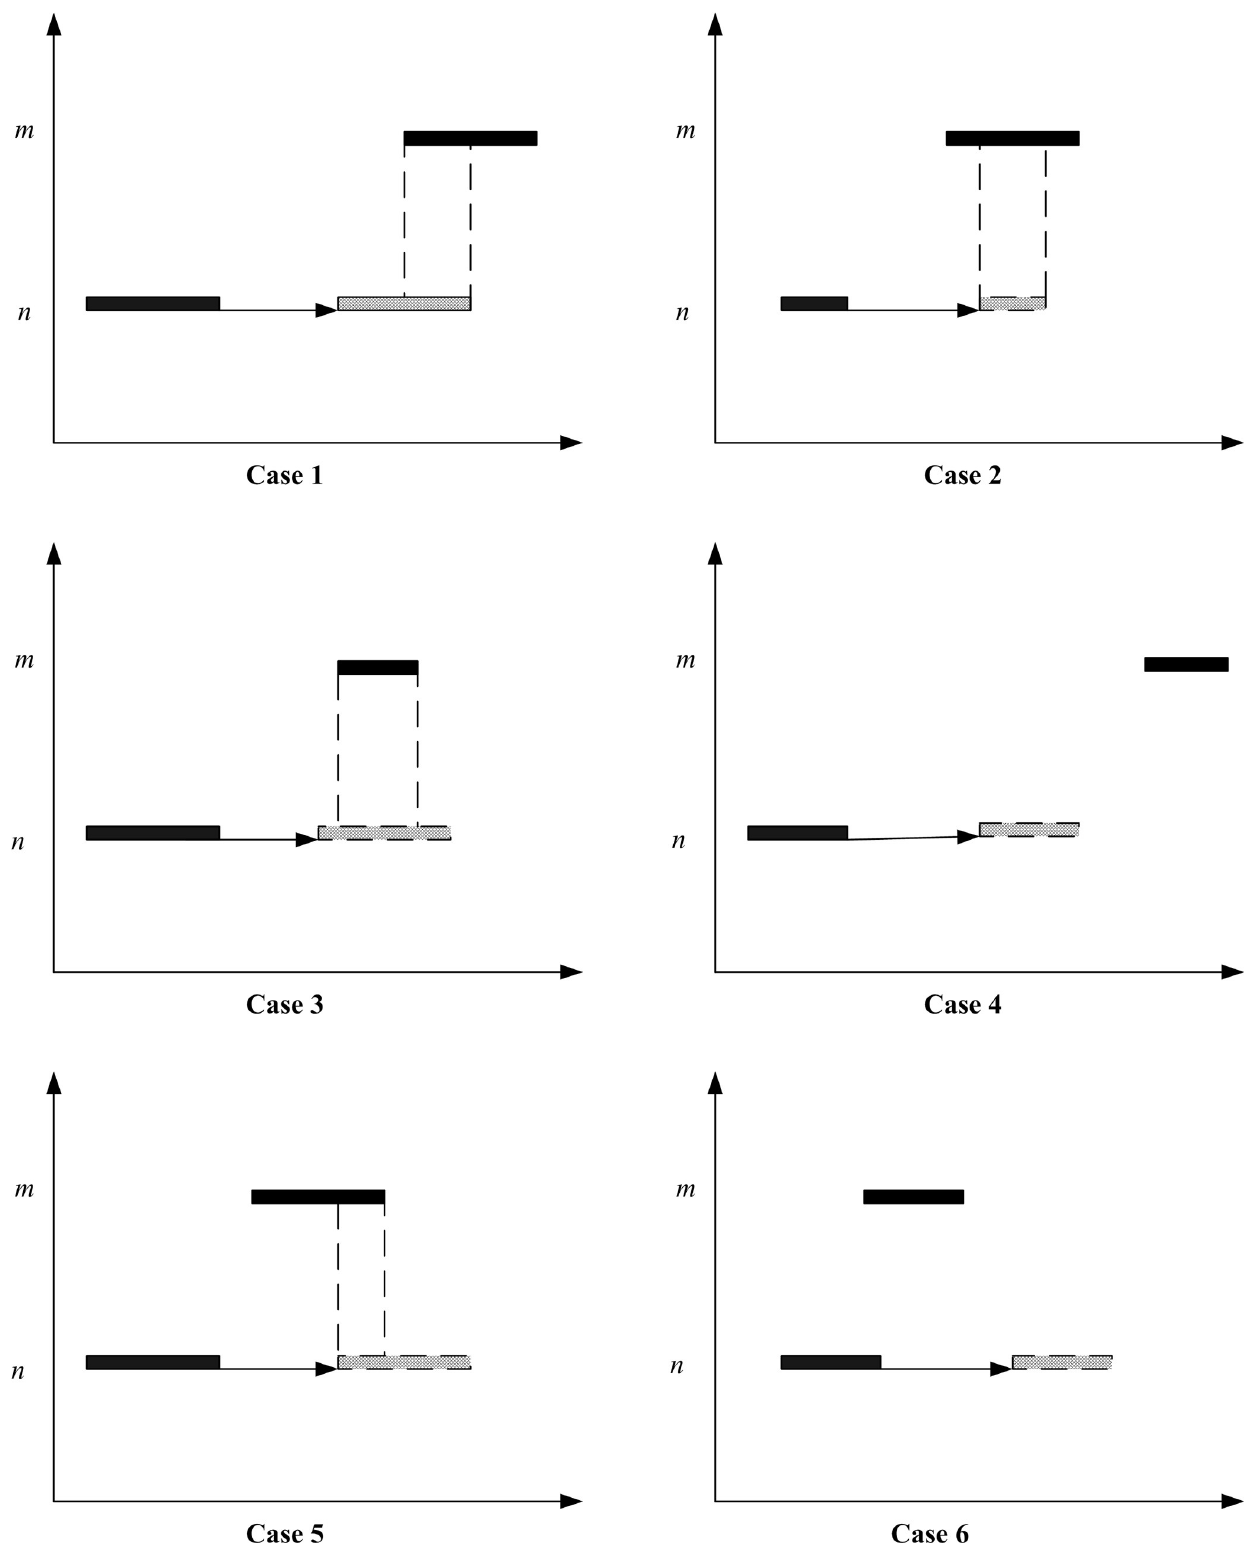
Fig 3. Six different patterns of traffic signal settings after transformation.